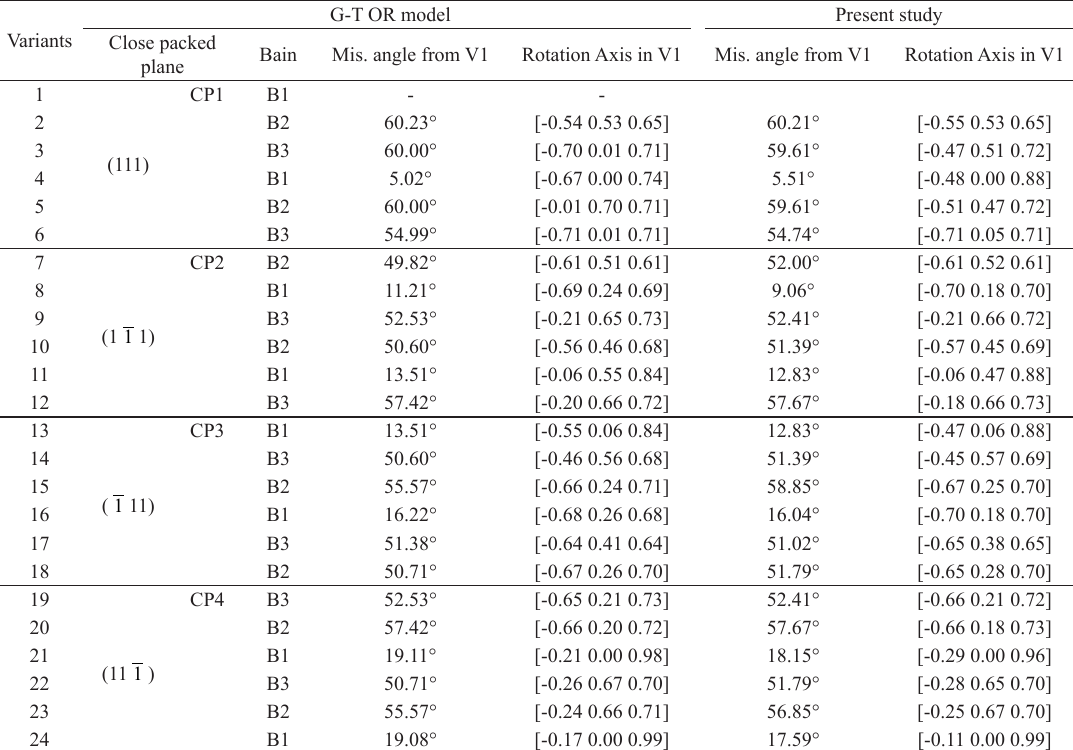
Figure 6. 24 martensite variants considering that the prior austenite orientation is (001)[100]: (a) G-T OR model and (b) average OR of AISI Table 2. 24 variants of G-T OR model and the average OR of AISI 420.